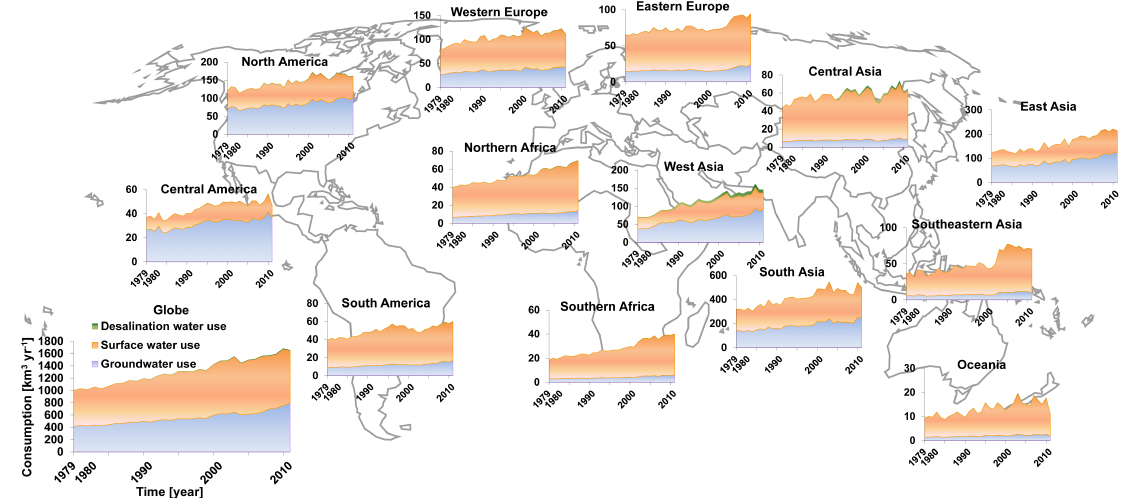
Fig. 6. Regional trends of consumptive water use per source (desalination water, surface water, and groundwater) over the period 1979–2010. The results were obtained from the mean of the simulation with the ERA-Interim and MERRA climate. The global figure is shown in the left